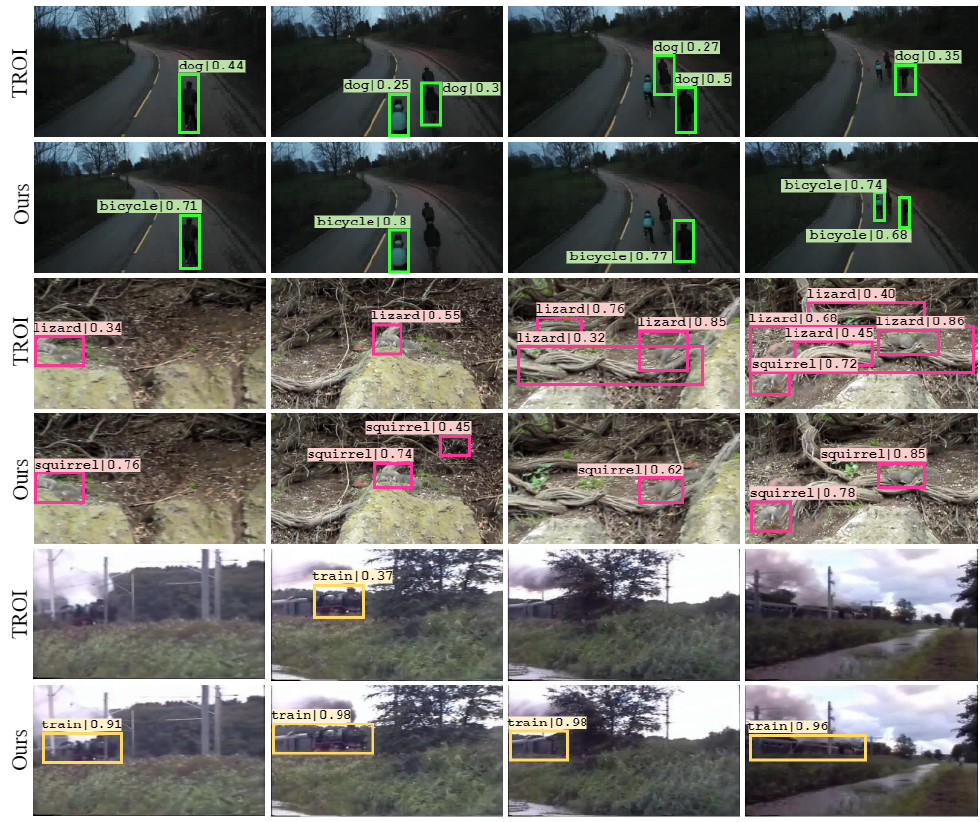
Figure 7. Visualising the performance of the proposed model against the baseline on the ImageNet VID dataset. Our model performs better in challenging conditions with fewer misclassifications and false